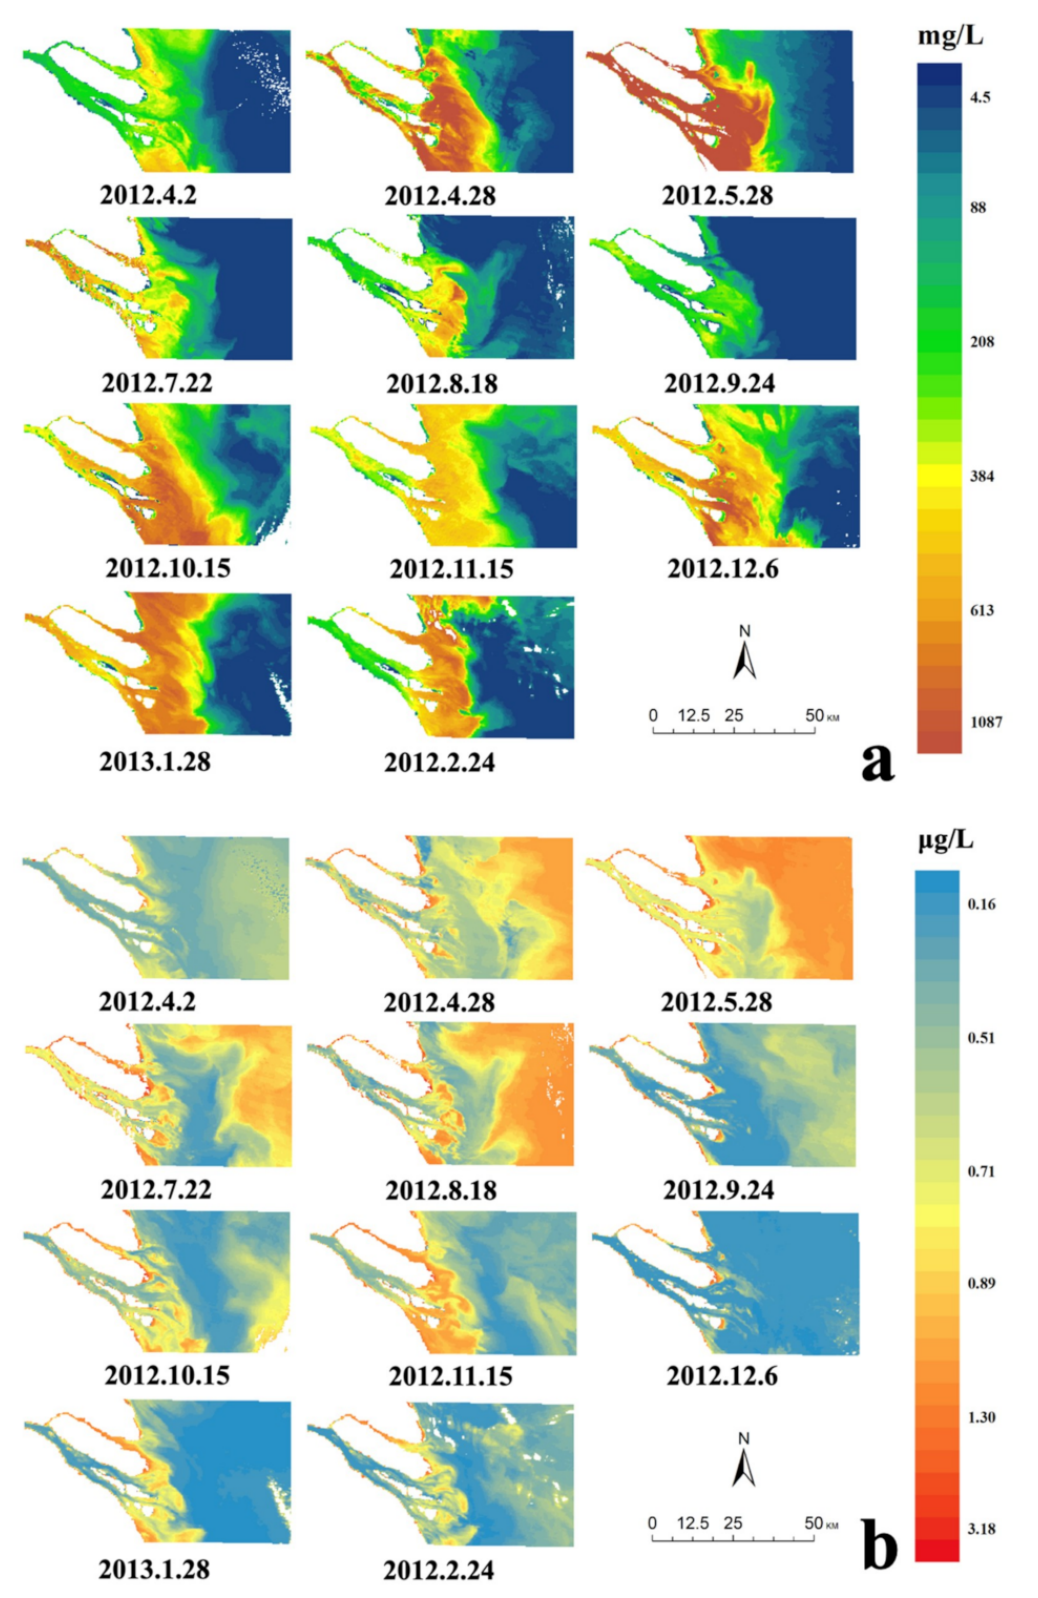
Figure 5. The spatial variations of TSS ( a ) and Chla ( b ) concentrations in time series for the study area. The white part of the picture represents the land- and cloud-covered